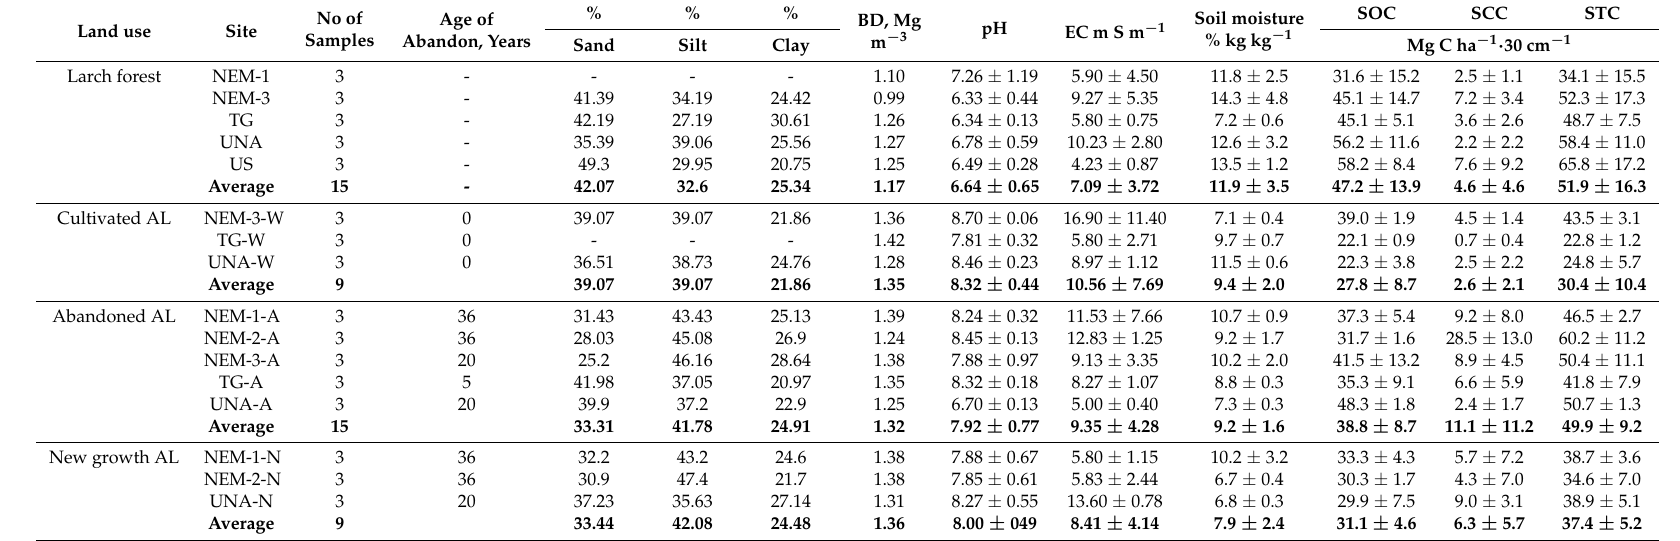
Table 2. Parameters of studied locations in different land